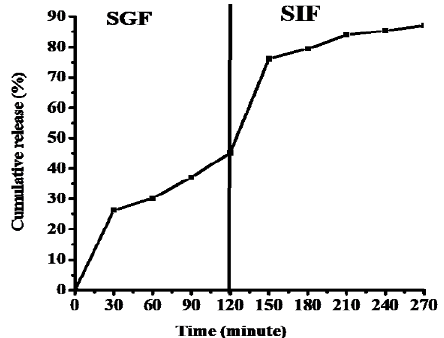
Figure 2. In vitro release of cod liver oil from alginate/lupin protein isolate complex beads in simulated gastric fluid (SGF) and simulated intestinal fluid (SIF).